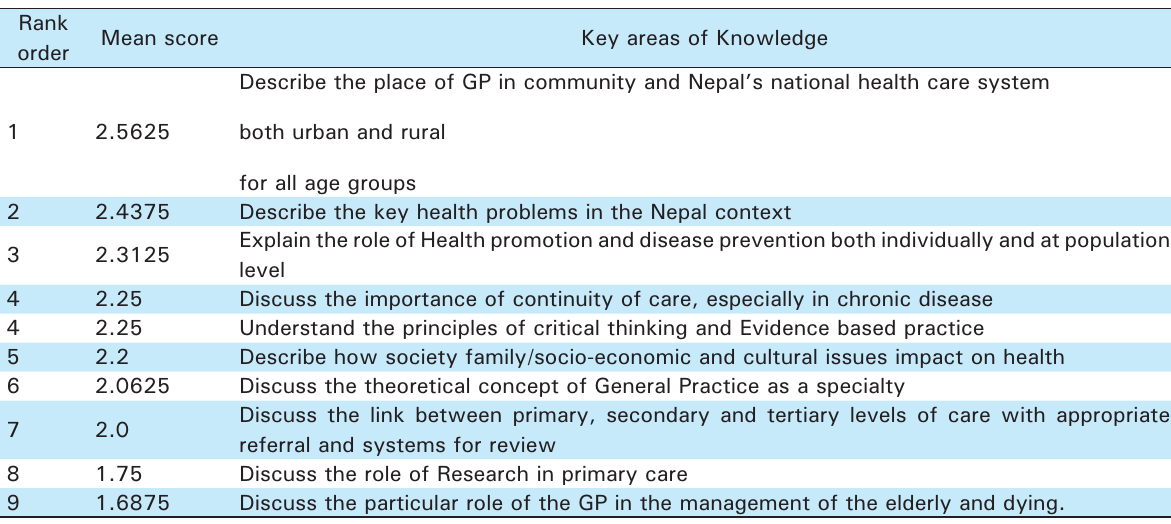
Table 1. Key areas of Knowledge for Undergraduates in General Practice